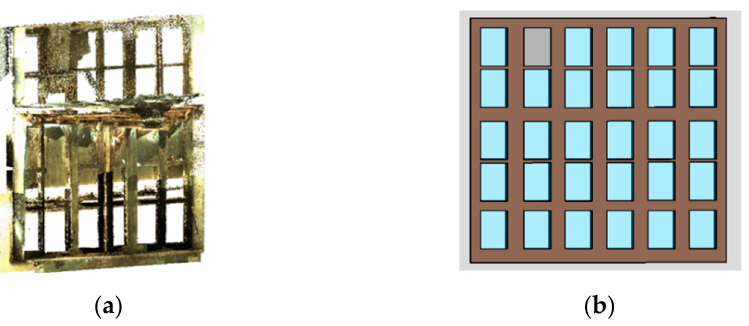
Figure 10. Creating the object library (window) starting from point cloud ( a ) to 3D BIM family ( b ).